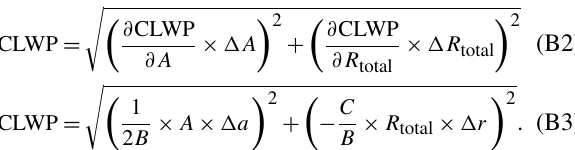
Figure B1. The extinction cross section per unit volume as a func- tion of the drop equivolume diameter for the two frequencies in the MWR (23.8 and